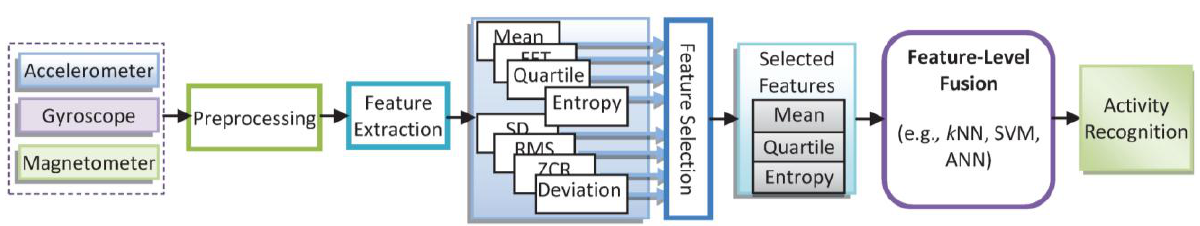
Figure 3. Activity recognition procedure using feature level fusion.